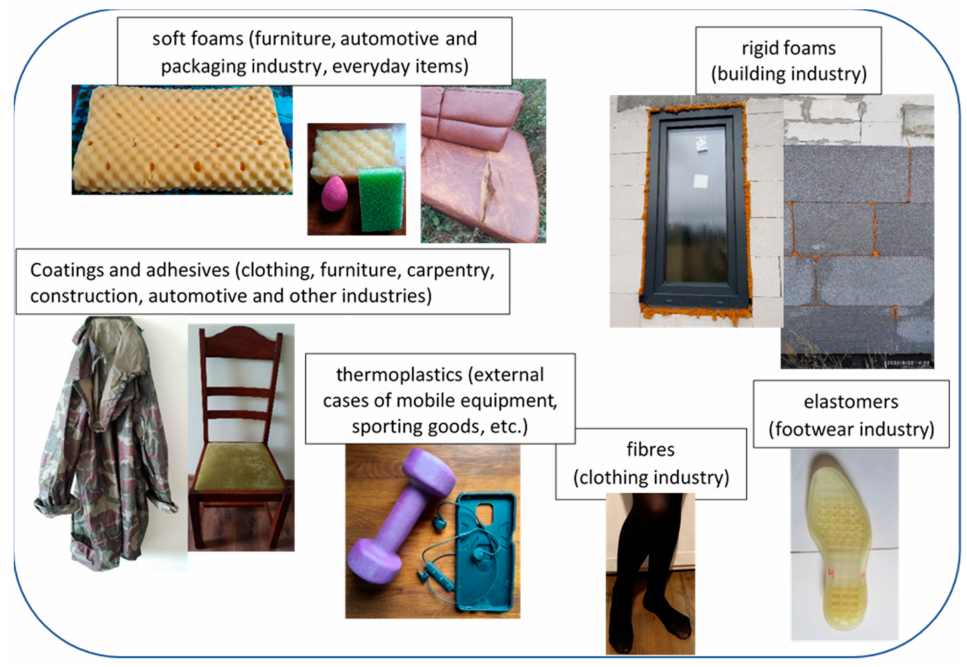
Figure 3. The most visible examples of the use of